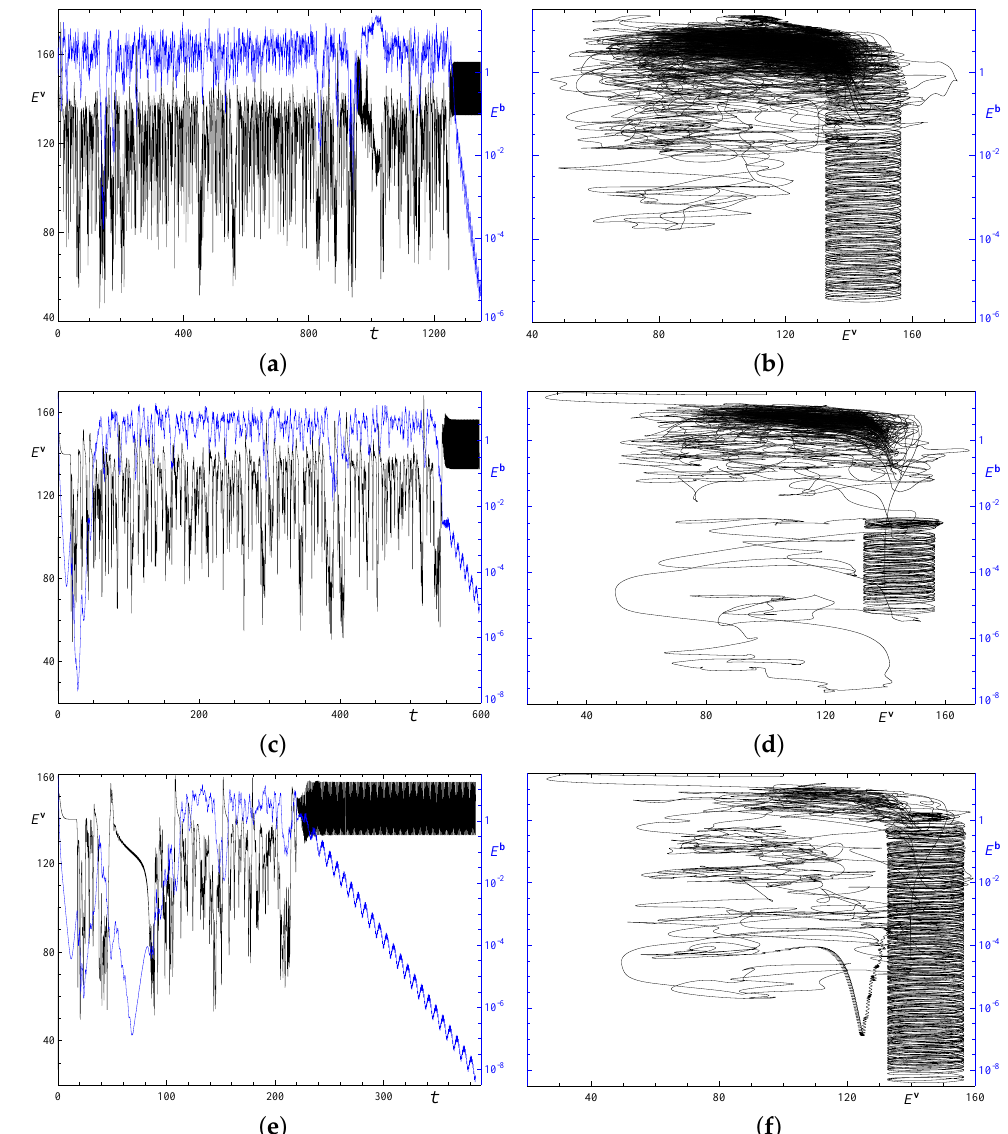
Figure 13. Temporal behaviour of the kinetic (left vertical axis, black line) and magnetic (right vertical axis, blue line) energies in triple-period runs (left column), and the projection of the trajectories on the plane of magnetic and kinetic energies (right column). Runs 3 x 1.1, (a), (b), and 3 x 1.2, (c), (d), with the standard space resolution (128 × 384 × 97 harmonics); and run 3 x 1.2, (e), (f), with the alternative resolution (256 × 256 × 257